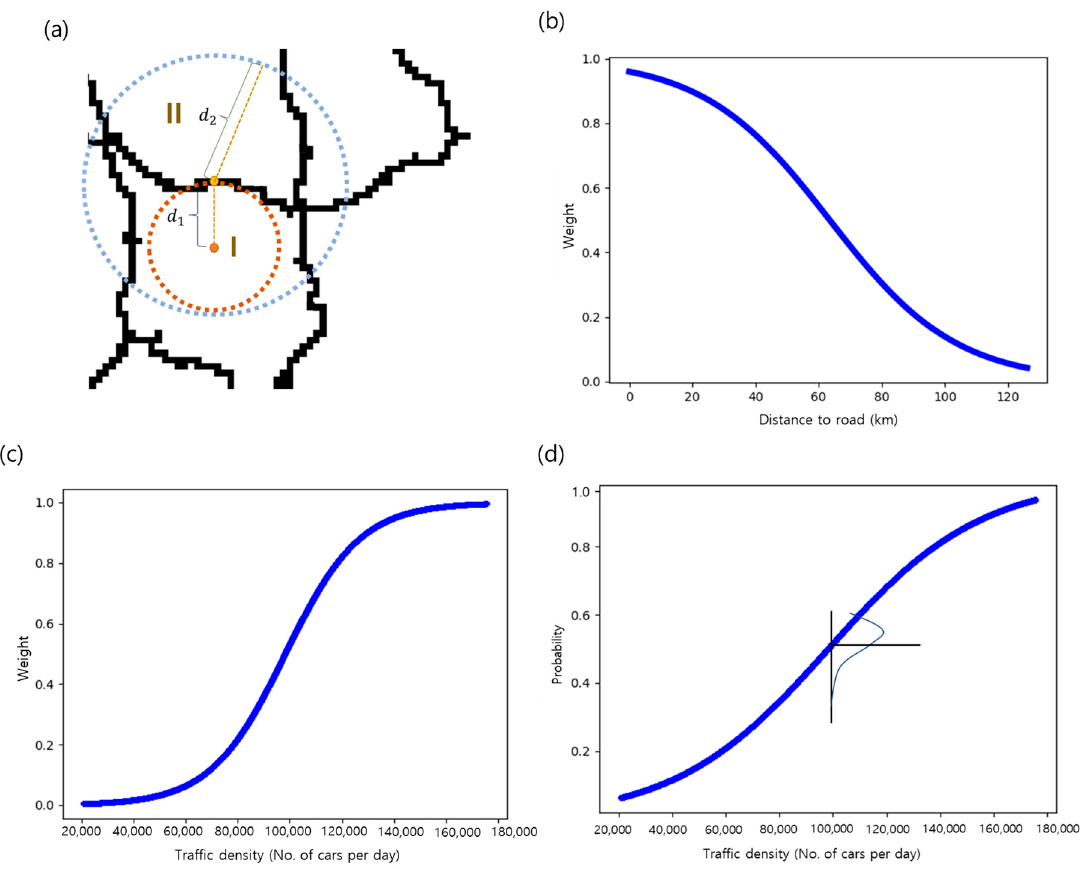
Figure 5. Two stages in passive movements in highway networks (The distance for the symbol d 2 is drawn intentionally short for simplicity of visualization). ( a ), probability of arriving at the road for Stage I according to distance to the road ( b ) and traffic load ( c ), and probability for dispersal distance for Stage II of passive movement according to traffic density (After the distance was determined by Equation (3), probability of dispersal in the model was generated according to the Poisson distribution) ( d ).